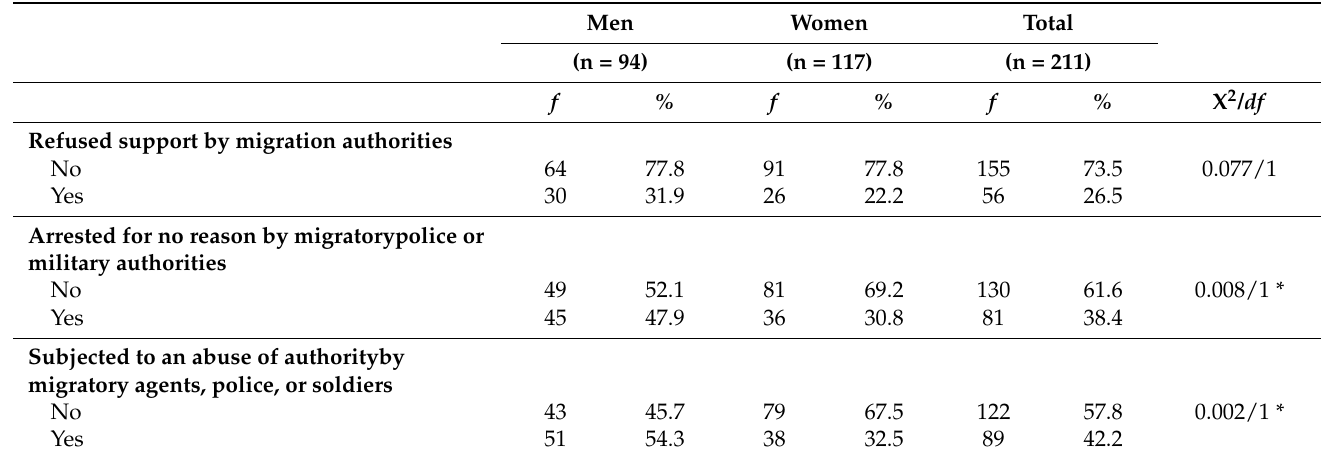
Table 4. During your last stay in Mexico, were